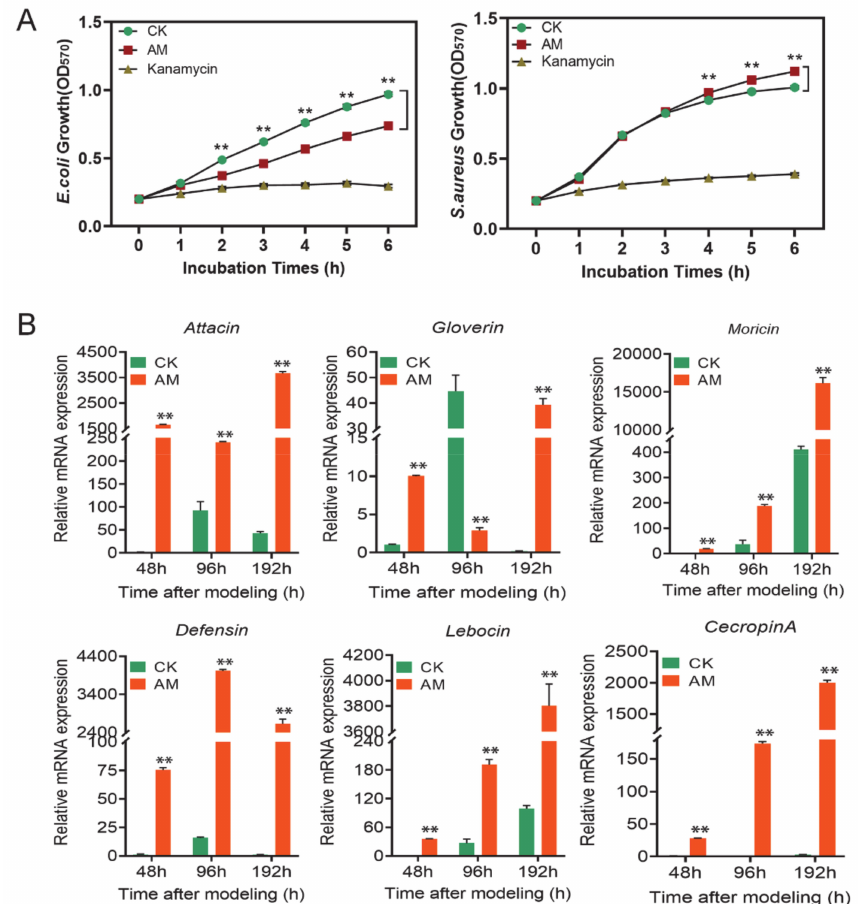
Figure 4. High PPC affected the antibacterial activity in hemolymph. ( A ) Antibacterial activity of high PPC silkworm cell-free hemolymph. The hemolymph of the silkworm was removed for heat treatment at 192 h after modeling, and the supernatant was cocultured with Escherichia coli ( E. coli ) and Staphylococcus aureus ( S. aureus ), and the growth of E. coli (left) and S. aureus (right) was investigated. ( B ) The mRNA levels of AMP genes in hemocytes from silkworm at 48–192 h after modeling. ** p < 0.01. Mean ± SEM. n =